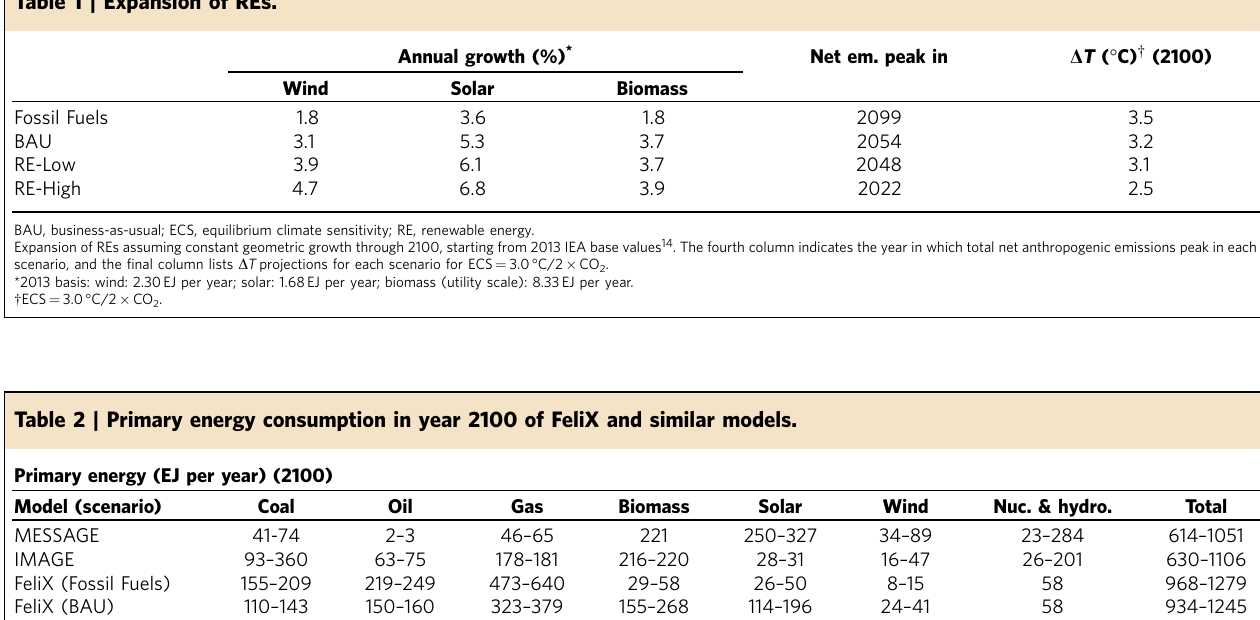
Table 1 | Expansion of REs.